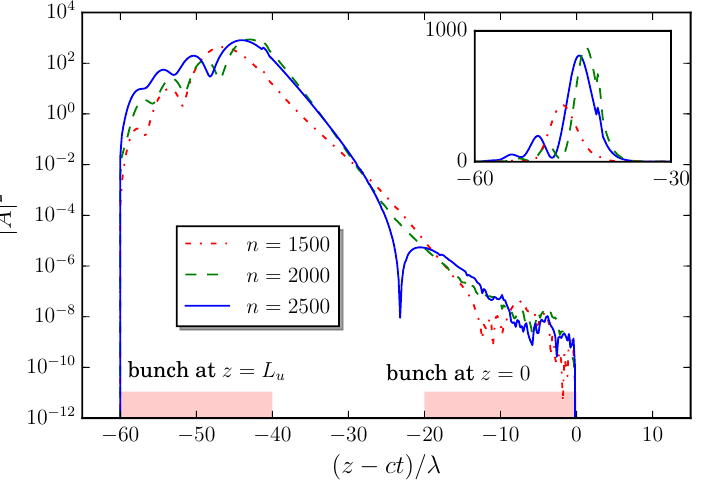
Figure 10. Temporal shapes of FEL pulses in a perfectly synchronized optical cavity simulated by one-dimensional code. Profile of the electron bunch at the entrance, z = 0, and the exit, z = L w , of the undulator is also plotted. The inset is the same FEL pulses plotted with a linear scale [39].